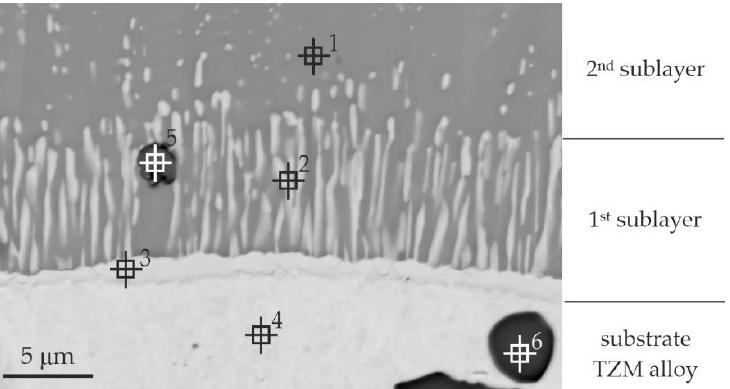
Figure 2. Microstructure (BEI) of a part of Si-Al coating (from the second group of samples) obtained on TZM alloy at temperature 1000 °C in 6 h with a quantity of slurry 0.3 g/cm 2 with points of X-ray microanalysis. Table 1. The results of the EDS point analysis of Si-Al coating according to Figure 2. Chemical Composition, % at Point of Analysis